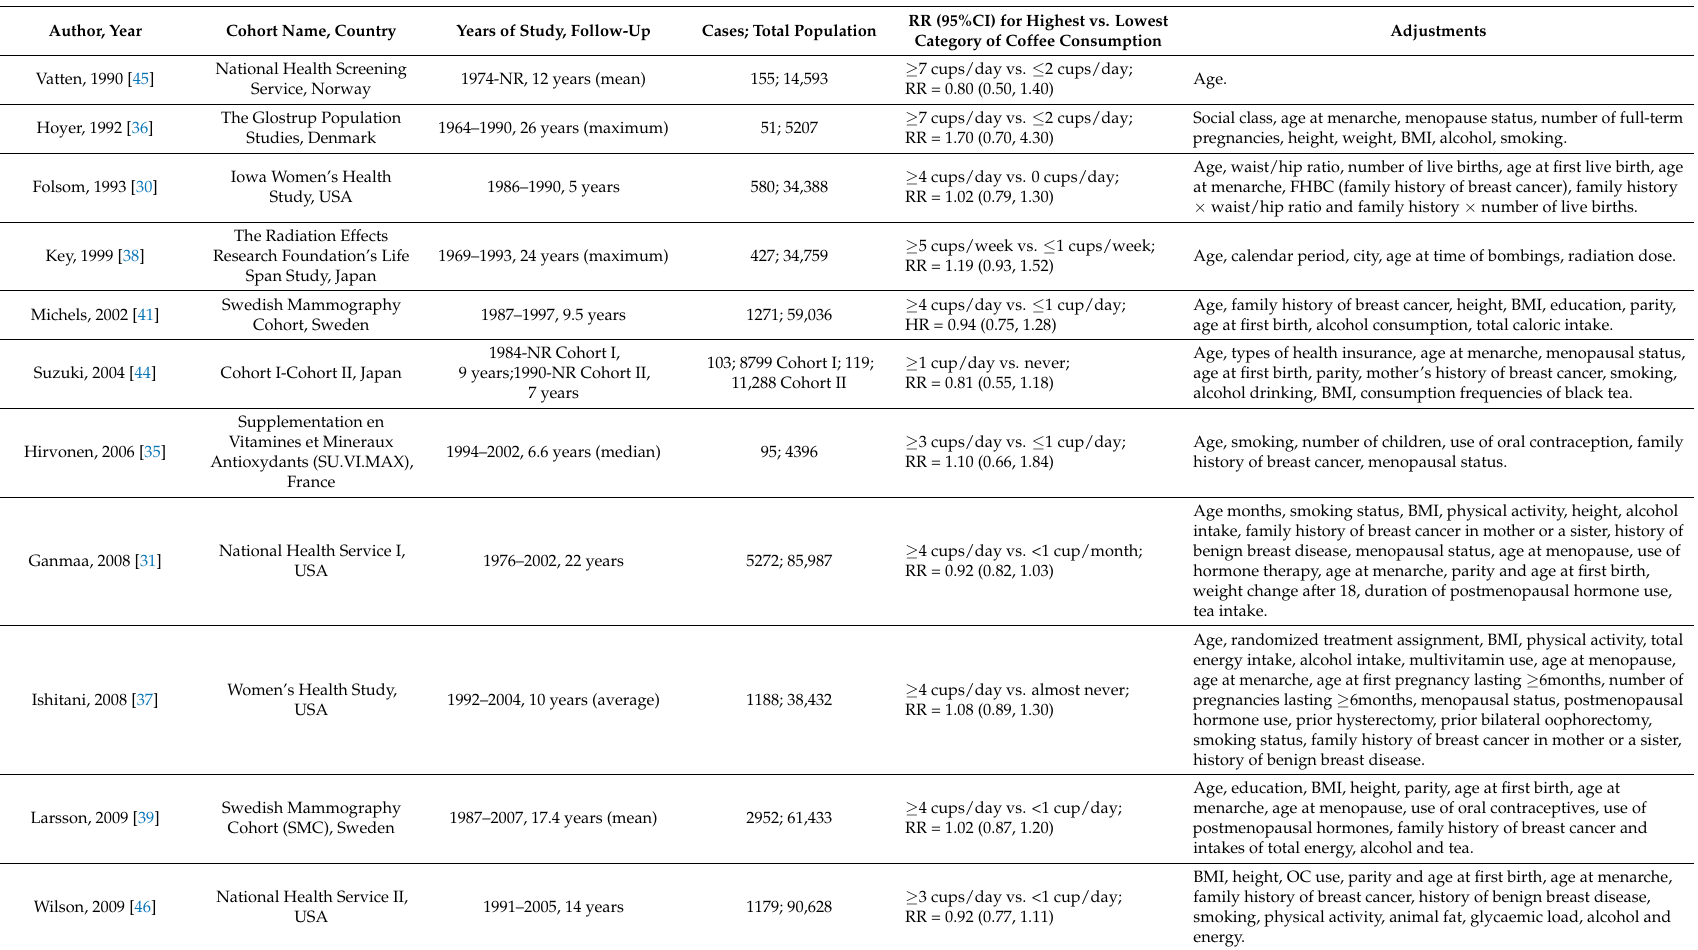
Table 1. Selected characteristics of the studies included in the meta-analysis. RR = relative risk. HR = hazard